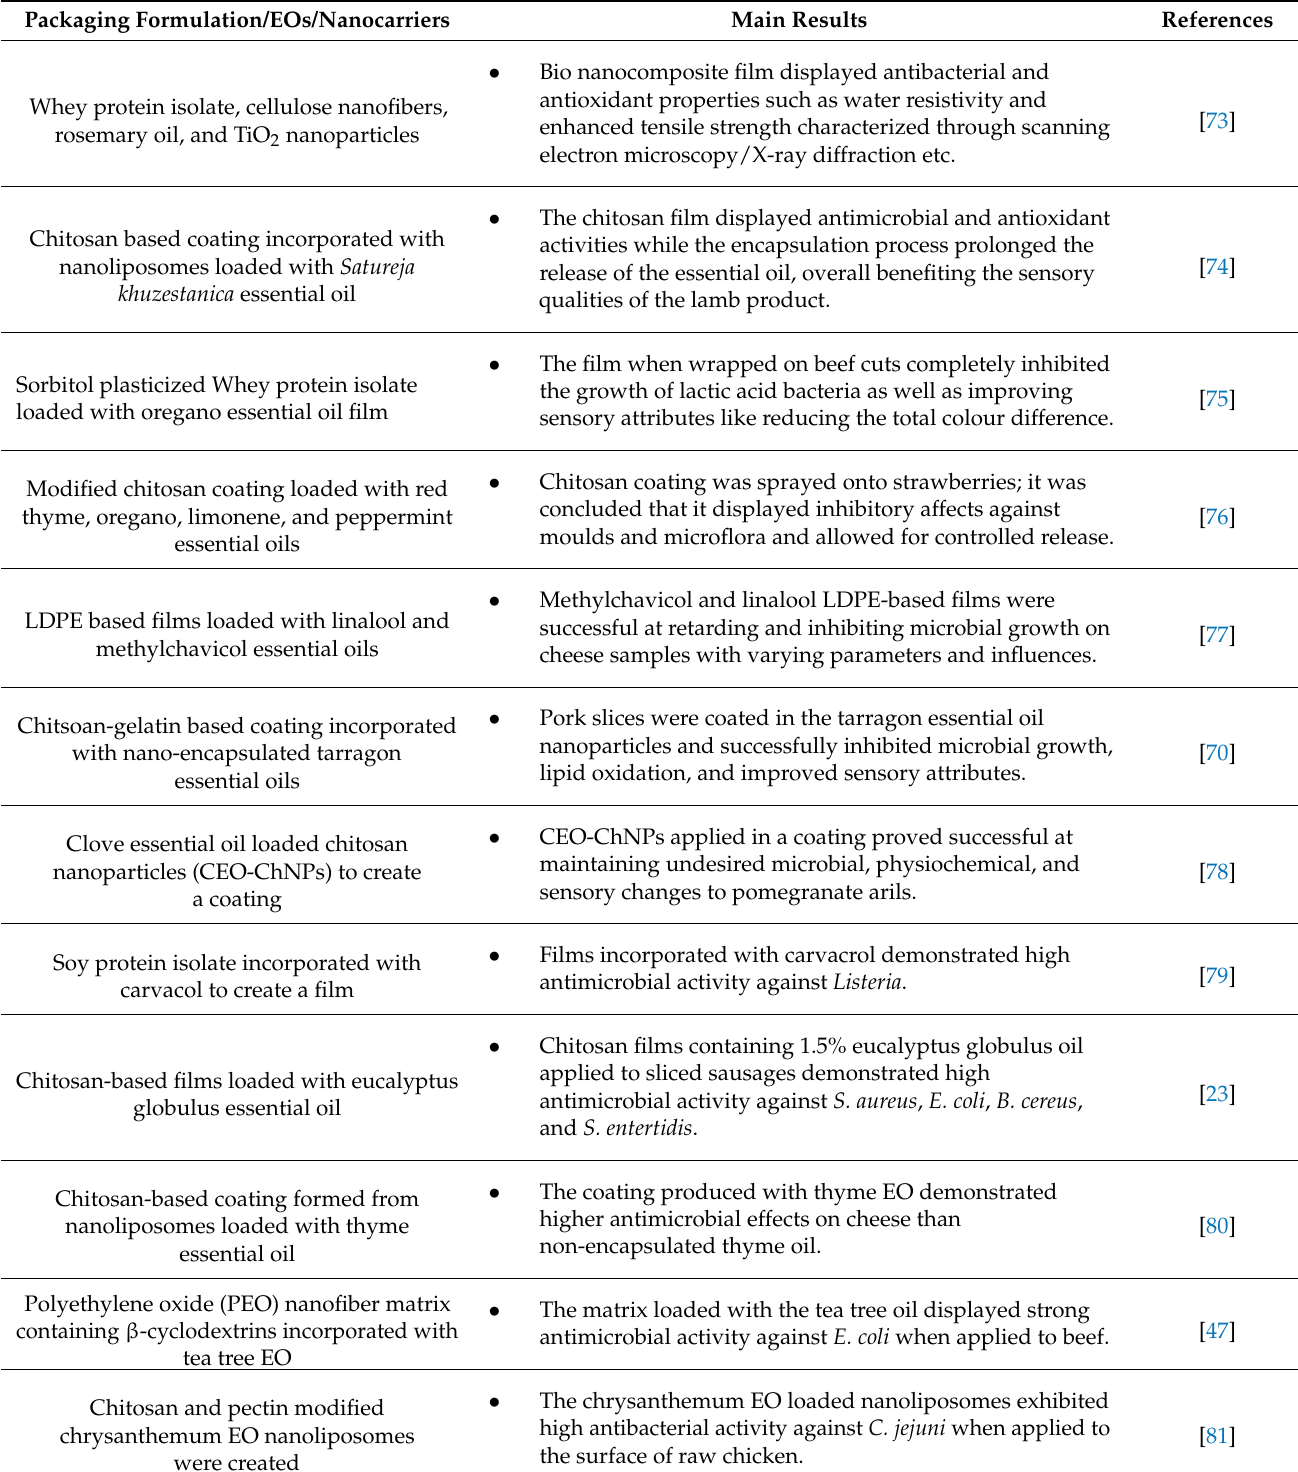
Table 2. Application of nonencapsulated essential oils (EOs) in antimicrobial active